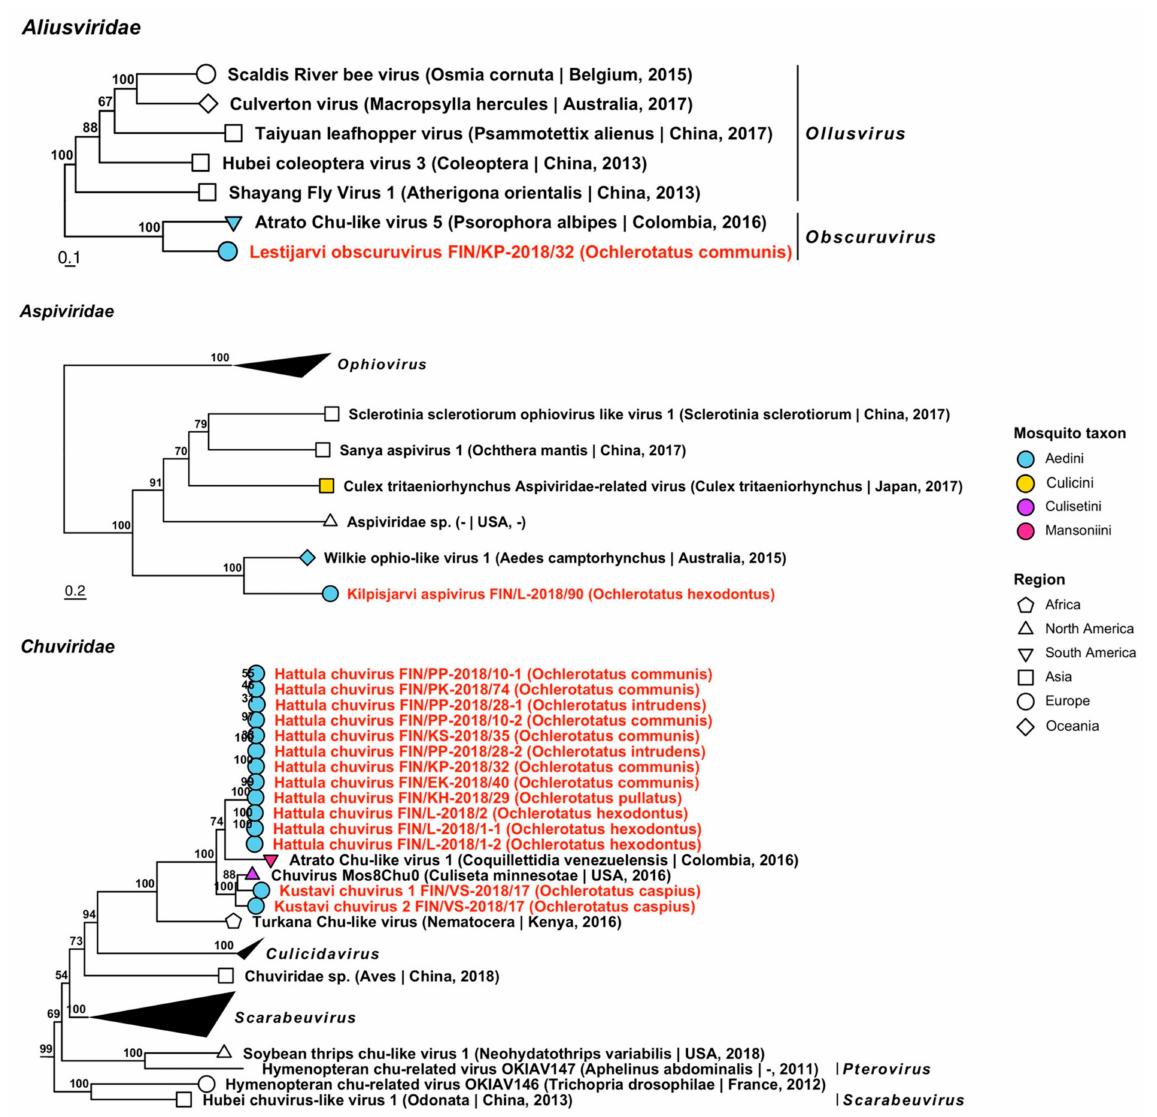
Figure 10. Maximum likelihood trees of Aliusviridae , Aspiviridae and Chuviridae . Tentative novel viruses are displayed in red and the mosquito species from which they were derived are in parentheses. Sequences from GenBank are black and display the following information after the virus or species name: “(sampled organism(s)|collection country, collection year)”. Tip colours represent the tribe of mosquito from which viruses were obtained. Tip shape represents the continent or region from which the specimens were collected. Trees were constructed from amino acid sequences of virus polymerases >1000 nt, aligned with MAFFT and computed with IQ-TREE2 using ModelFinder and 1000